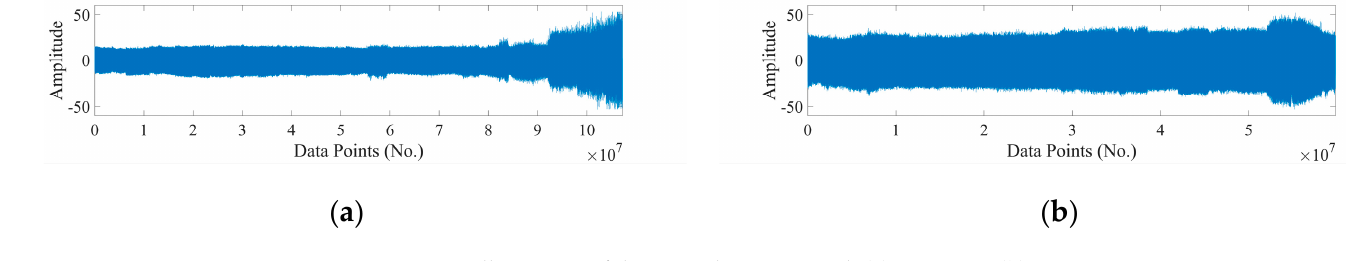
Figure 12. Illustration of the raw vibration signal. ( a ) Dataset 1, ( b ) Dataset 2. Table 7. Data description of the rotary torsional fatigue test.